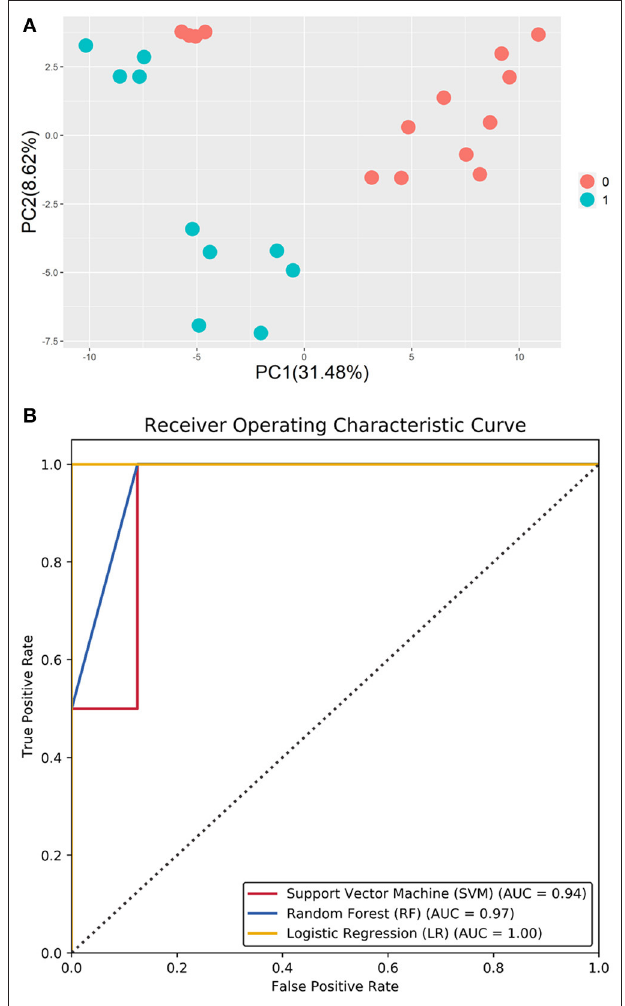
FIGURE 5 | (A) PCA of the methylation profiles of DMGs, showing a remarkable separating plane between different methylation patterns. (B) Area under the curve (AUC) of the machine learning